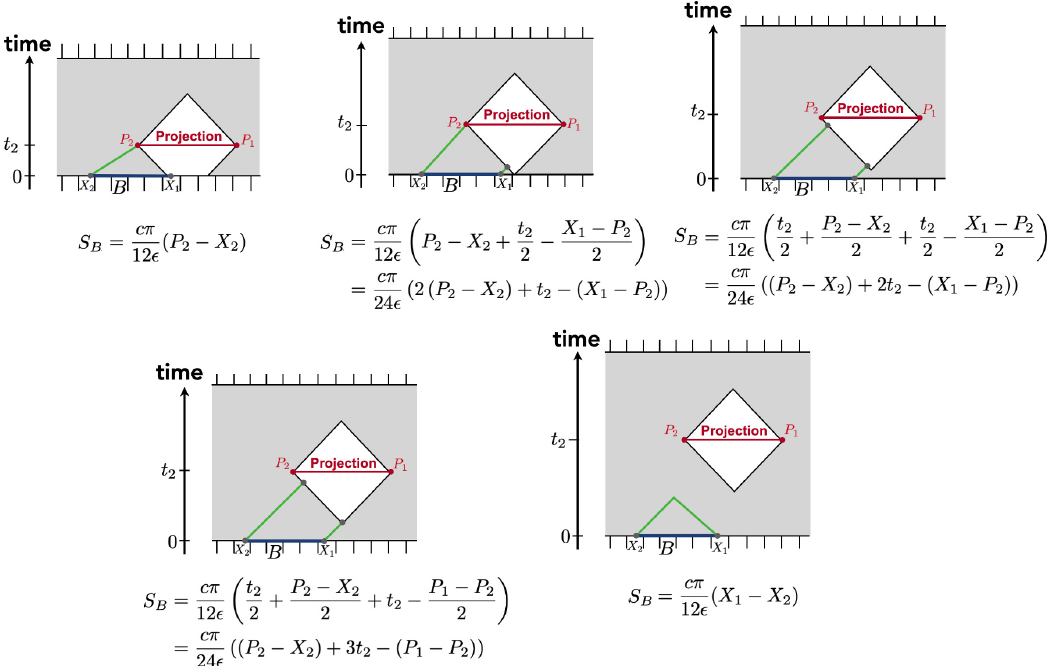
Figure 10 . Diagrams for the line-tension picture in Case